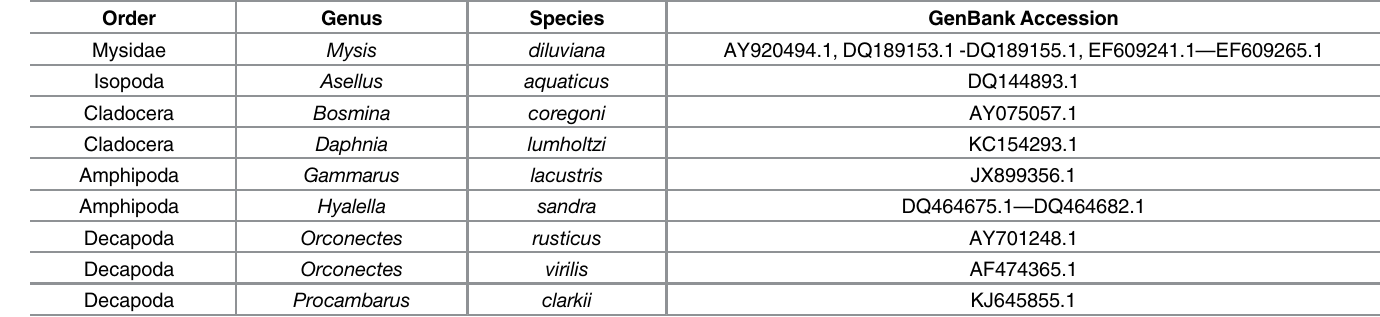
Table 1. A list of species and corresponding GenBank accession number for sequences used in marker development.